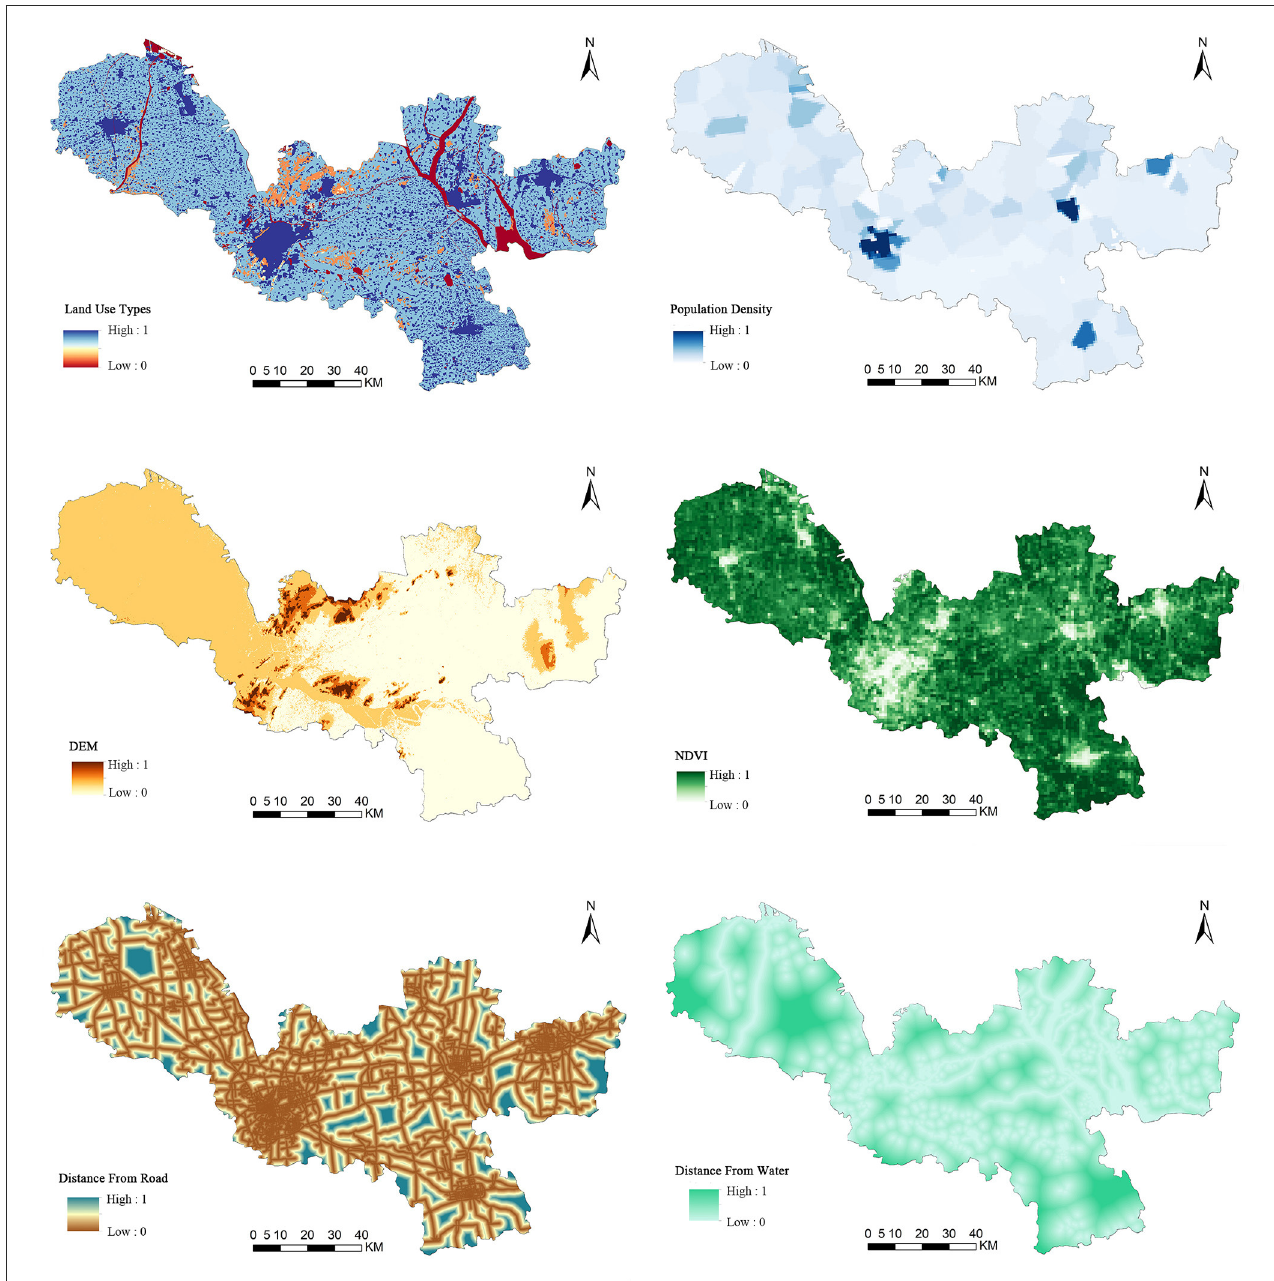
FIGURE3 Spatial distribution of ecosystem service demand in